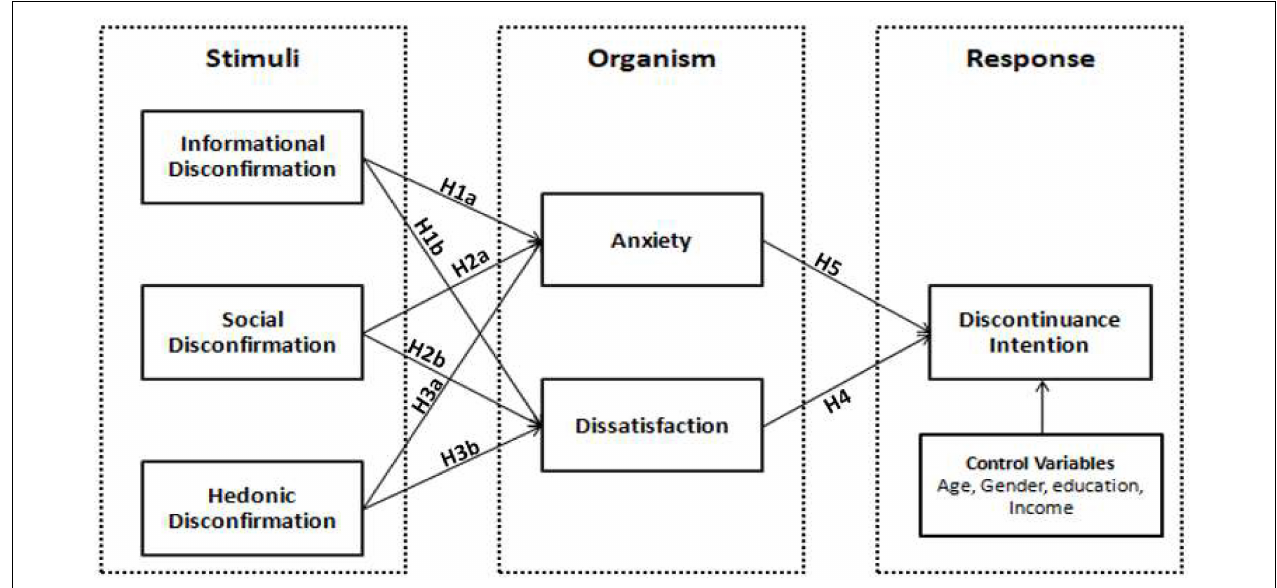
FIGURE 1 | The diagram presents the framework based on the SOR paradigm.